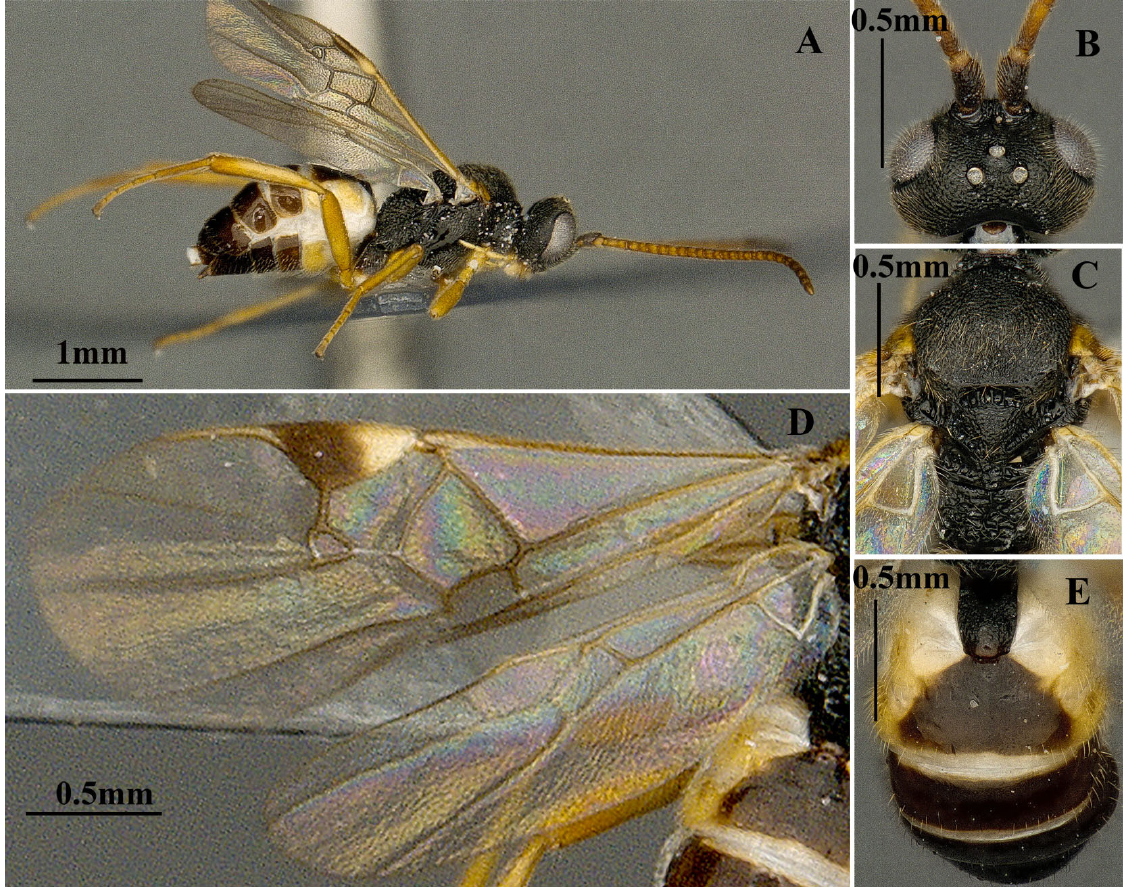
Fig. 7. Microplitis mandibularis Thomson, 1895, ♀, TMUC-HBMMP0051. A . Habitus, dorsal view. B . Head, dorsal view. C . Mesosoma, dorsal view. D . Wings. E . Metasoma, dorsal